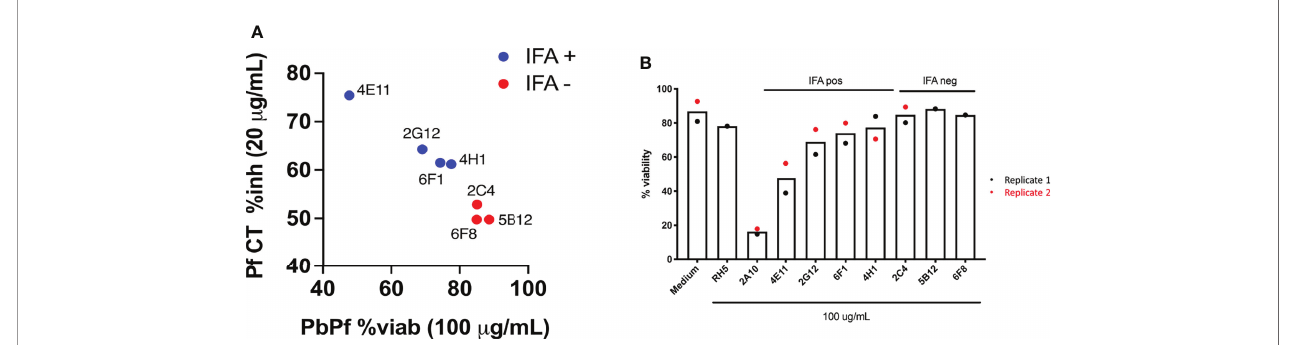
FIGURE 4 | (A) Inhibition and cytotoxicity of recombinant IgG1 (rIgG1) against Pf CSP from cell culture supernatants. Cell traversal (CT) inhibition (y-axis) of Pf NF54 sporozoites is shown against viability of P. berghei Pf CSP transgenic parasites following incubation with the various mAbs. To note, cytotoxic activity in PbPf CSP sporozoites correlates with inhibition of Pf CT. Antibodies that do not bind to the Pf CSP on the sporozoite surface (red) are non-cytotoxic. IFA, immuno fl uorescence assay. (B) Viability of transgenic P. berghei Pf CSP parasites following incubation with cell culture supernatant containing recombinant anti- Pf CSP rIgG1. Controls included in the assay were cell culture medium alone and a recombinant anti- Pf RH5 rIgG1. The recombinant antibodies generated had a limited effect on sporozoite viability with 4E11#20 showing a moderate reduction in viability.